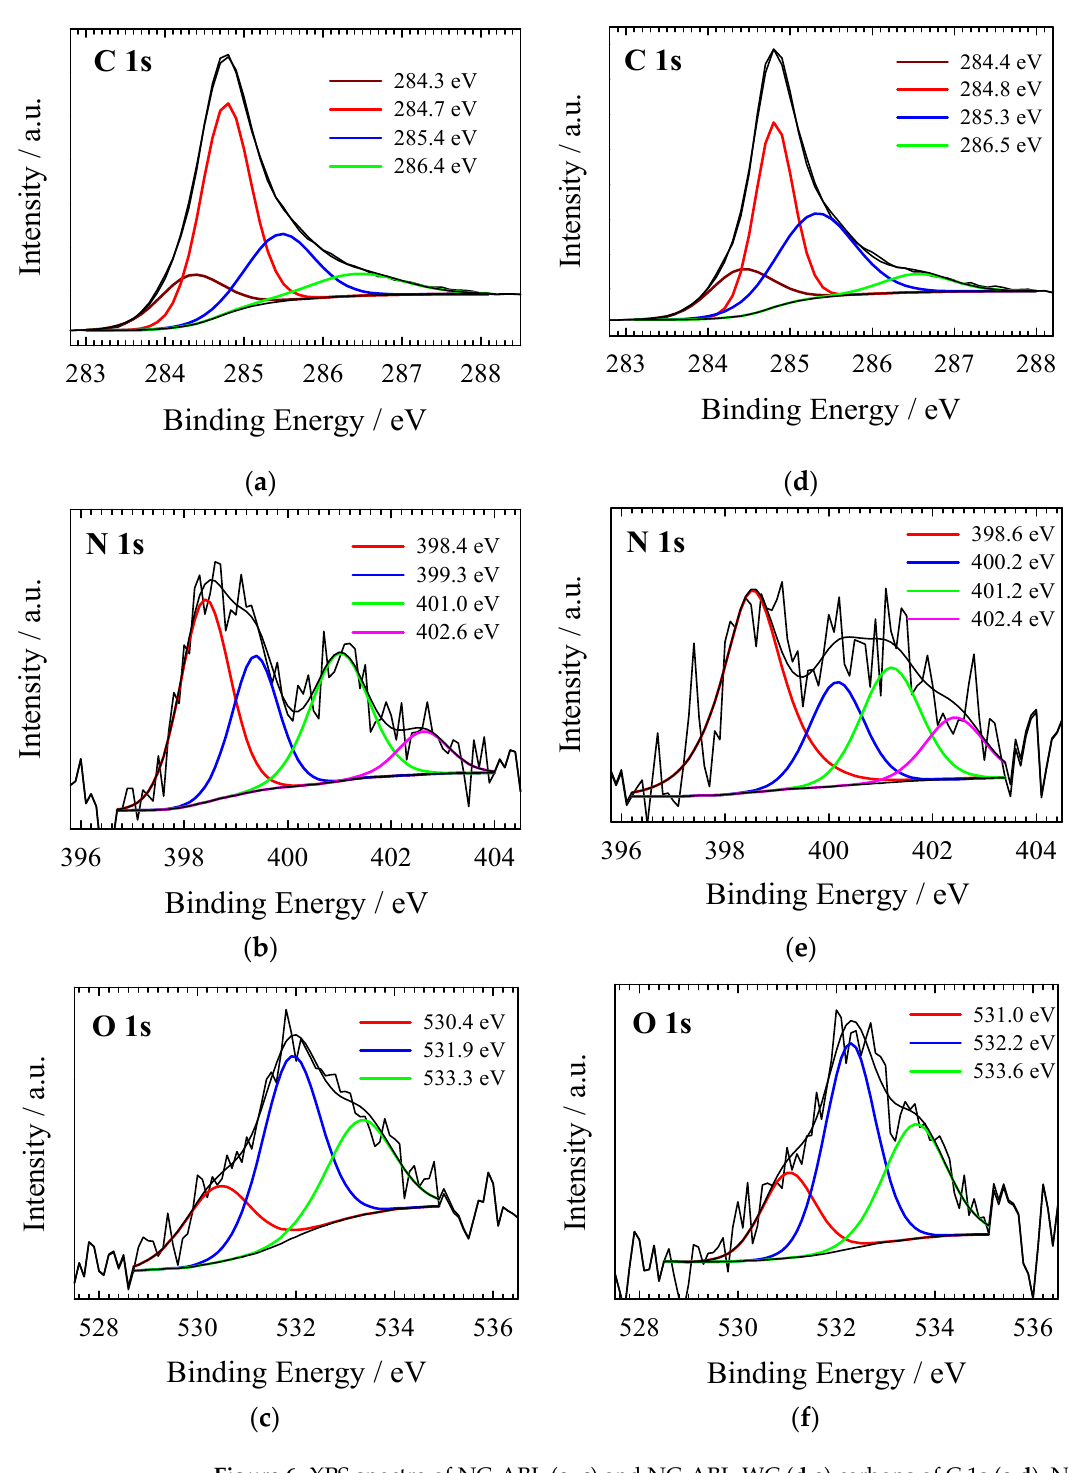
Figure 6. XPS spectra of NC-ABL ( a – c ) and NC-ABL-WC ( d , e ) carbons of C 1s ( a , d ), N 1s ( b , e ), and O 1s ( c , f ).